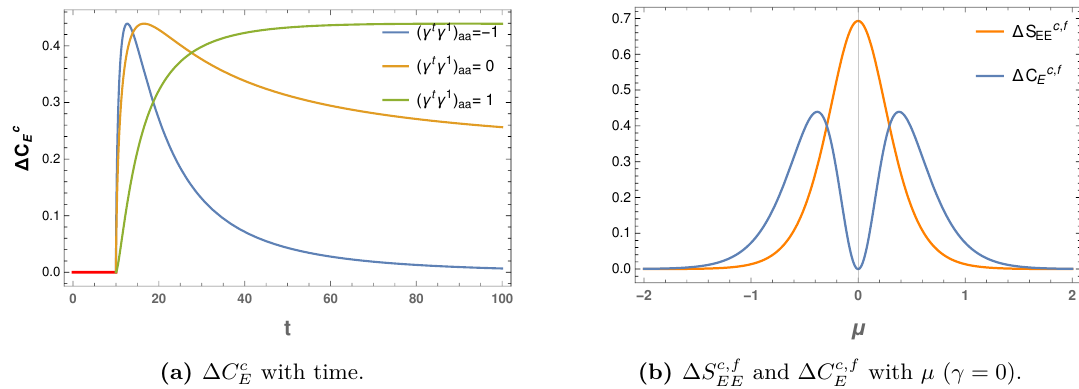
Figure 5. (a) Late-time behavior of charged capacity. Note that for γ = 0 , the capacity does not approach to zero, in contrast with uncharged case. We set µ = 1 / 2 π . (b) Variation of the final value of entanglement entropy ( ∆ S c,f ) and capacity ( ∆ C c,f ) with chemical potential for γ = 0 . EE E Here we choose L = 10 . The red line in (a) corresponds to t < L